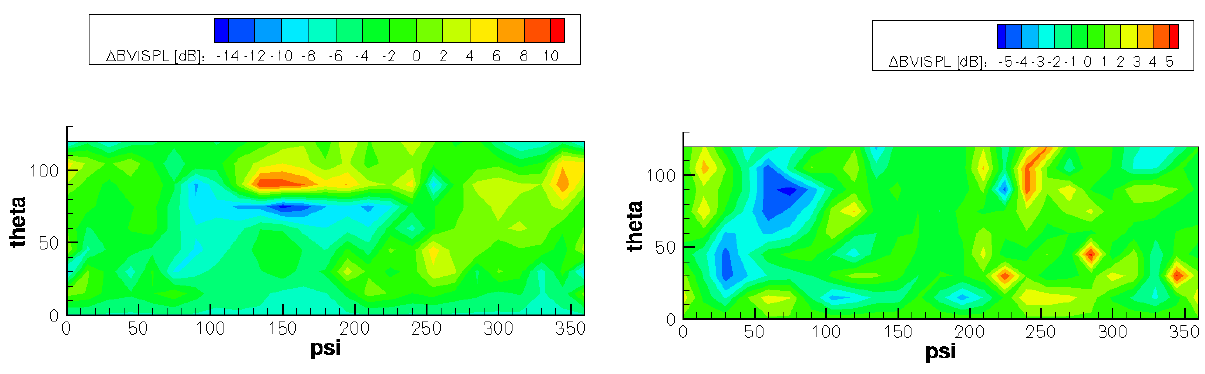
Figure 15: Technique A – B differential BVISPL at point 3 in maneu- ver ID8021.